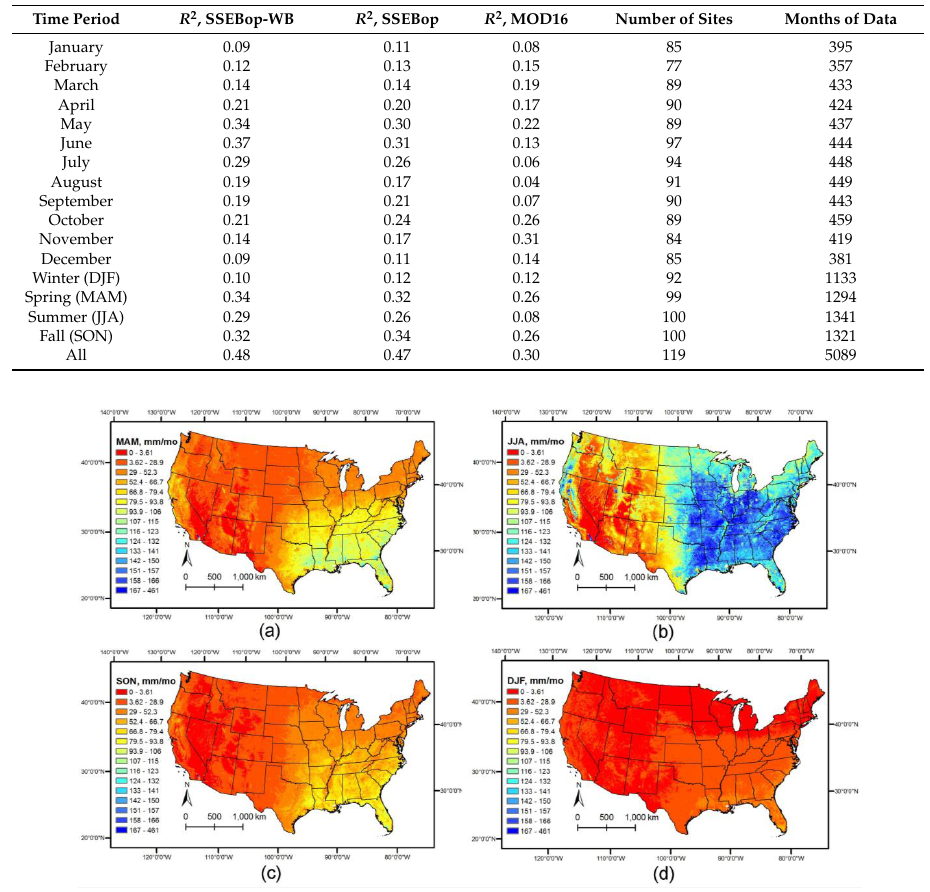
Figure 9. Seasonal averages of the monthly SSEBop-WB data set, for the 2000–2015 time period: ( a ) Spring (March, April, May); ( b ) Summer (June, July, August); ( c ) Fall (September, October, November); and ( d ) Winter (December, January, February).